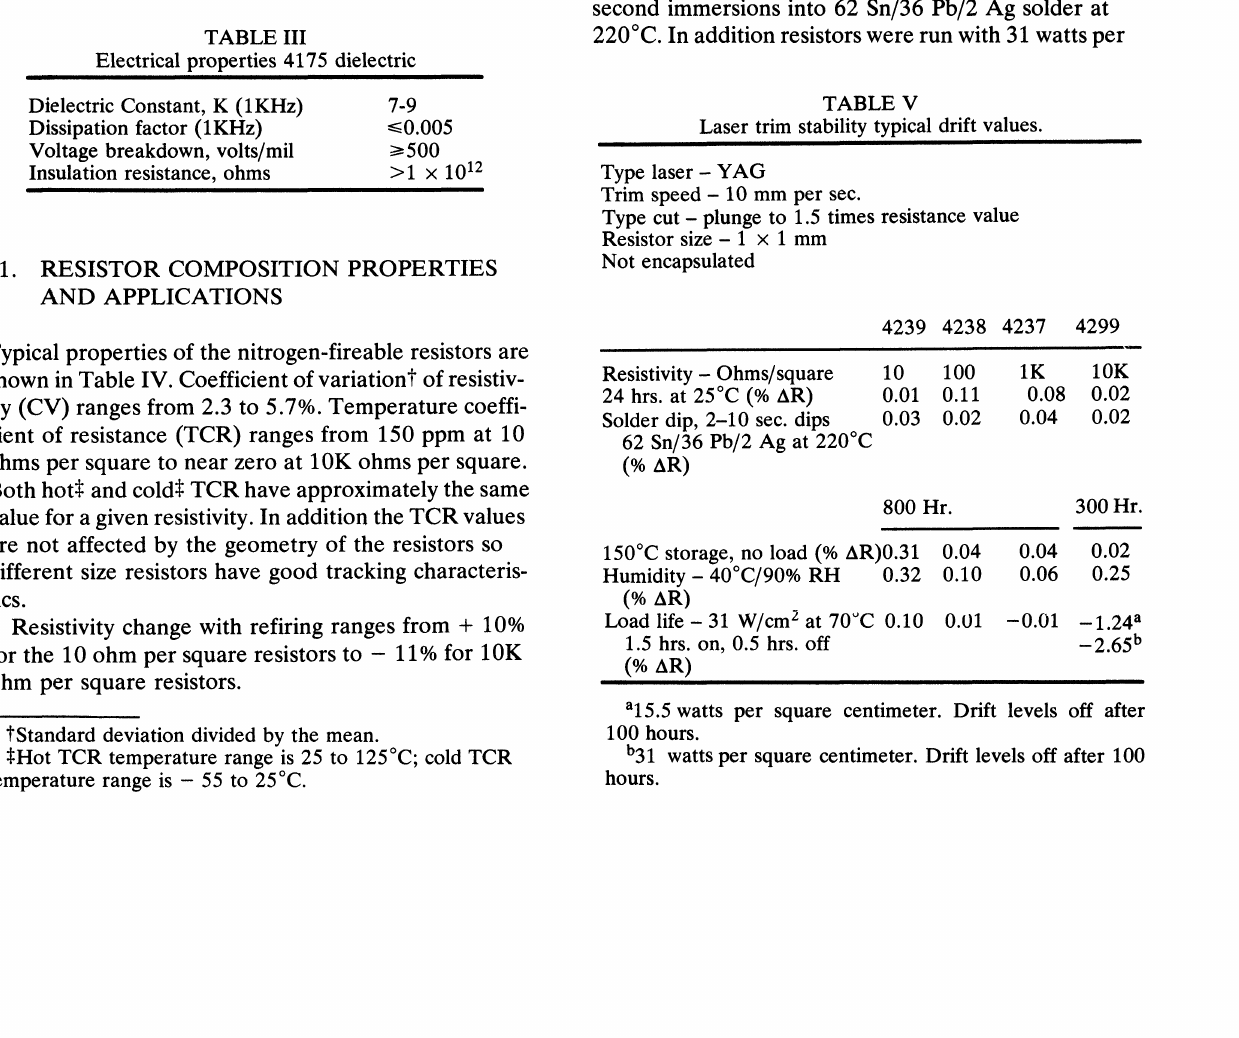
TABLE III Electrical properties 4175